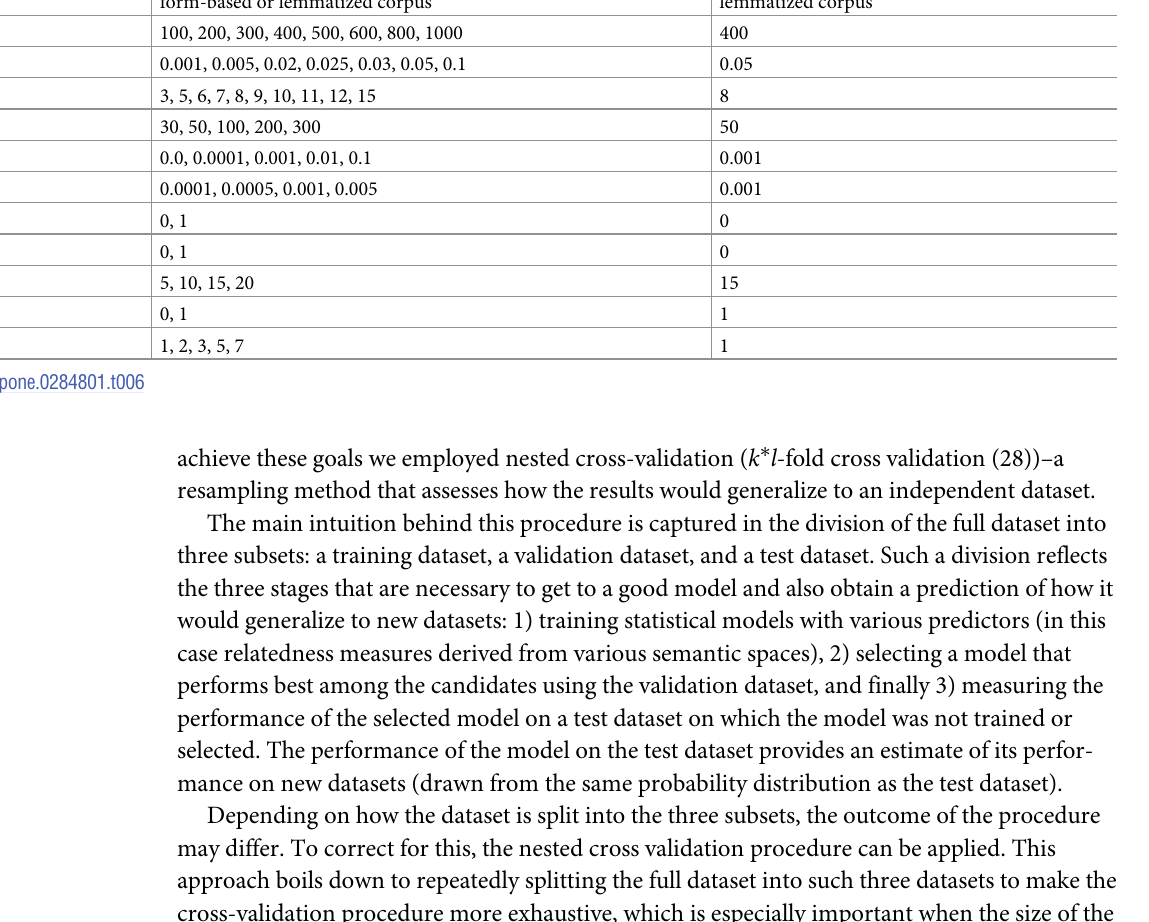
Table 6. List of hyperparameters and possible values, and hyperparameter values of the semantic space identified as optimal. For more information about the mean- ing of each hyperparameter see gensim documentation (https://radimrehurek.com/gensim/models/word2vec.html#gensim.models.word2vec.Word2Vec).